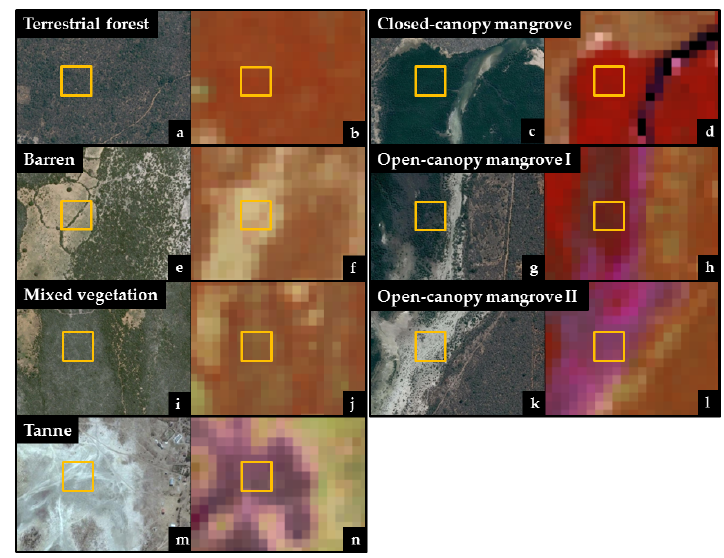
Figure 3. The appearance of each of the seven mapped classes as viewed in high resolution Google Earth imagery ( 3a, 3c, 3e, 3g, 3i, 3k and 3m ) and a Landsat false color composite ( 3b, 3d, 3f, 3h, 3j and 3n ). The Landsat false color composite utilizes band 5 (near-infrared) in the red channel, band 4 (red) in the green channel and band 3 (green) in the blue channel. The yellow polygons represent 3 × 3 pixel (90 m × 90 m) reference areas. Table 2. Summary of the finalized map classes, their descriptions and the number 3 × 3 pixel of calibration and validation areas used to train/test the maximum likelihood algorithm for each class.